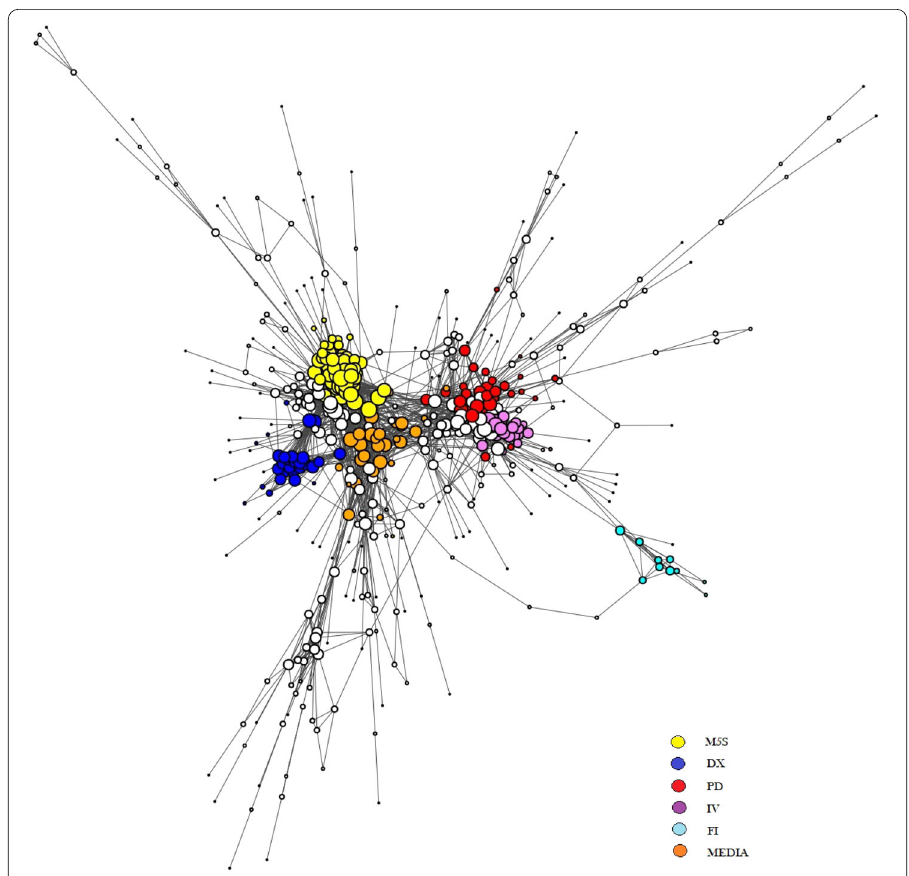
Figure 1 TheLargestConnectedComponent(LCC)ofthevalidatednetworkofverifiedaccounts . Two verified users are connected if they share a statistically significant number of neighbours in the bipartite network, i.e. if a sufficiently high number of non-verified users has retweeted both of them compared with the expections of the BiCM [25]. The main communities described in the text are pictured with different colors, nodes belonging to smaller communities are in white. The network is represented using Fruchterman–Reingold